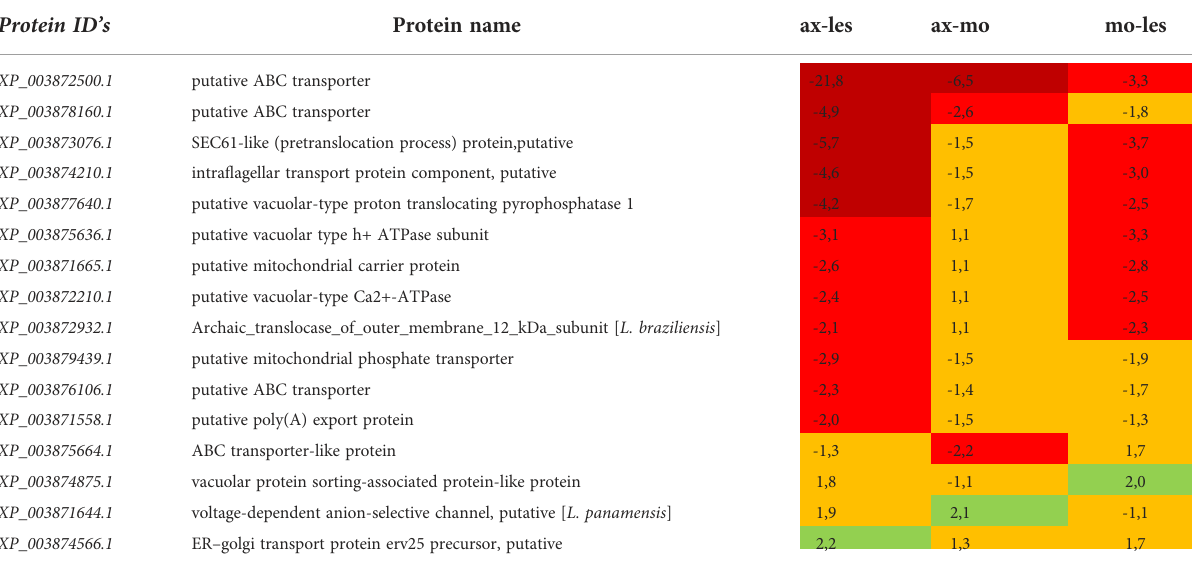
TABLE 10 Transmembrane transport proteins identi fi ed in all 3 comparisons that differ by at least 2-fold (T-test signi fi cant) between individual amastigote types. Transmembrane transport Protein ID ’